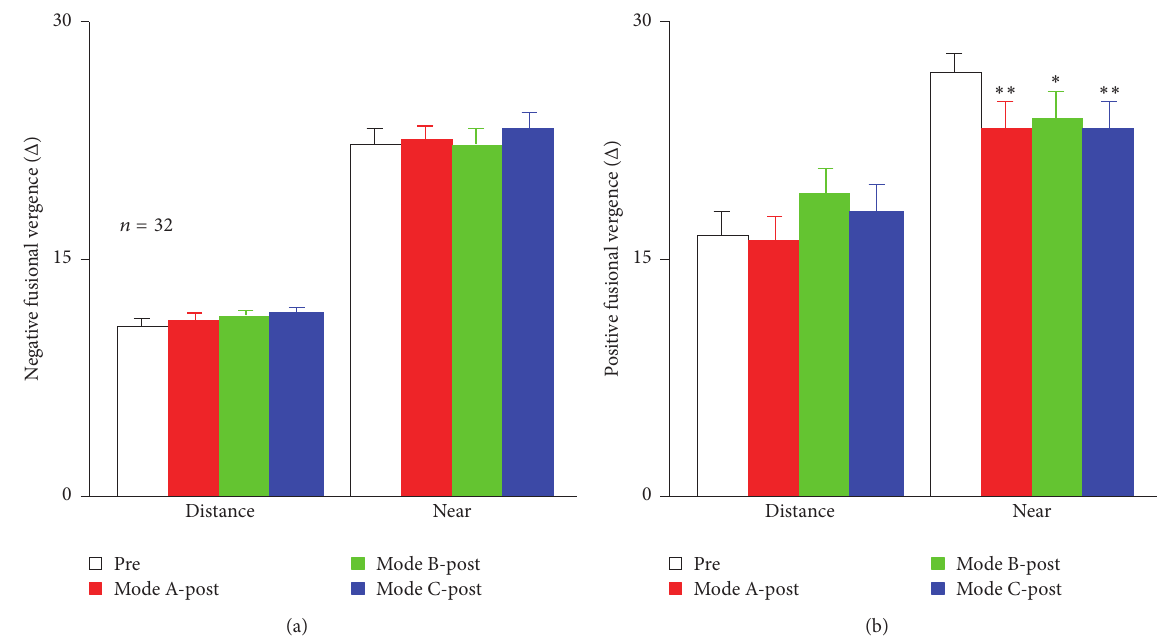
Figure 7: The effect of a 90-minute 3D viewing session on fusional vergence. The effect of a 90-minute 3D viewing on negative fusional vergence (a) and positive fusional vergence (b), which were measured at distant and near measuring conditions. Error bars indicate the standard error across 32 observers; ∗ 𝑝 < 0.05 ; 0.05 < ∗∗ 𝑝 < 0.01